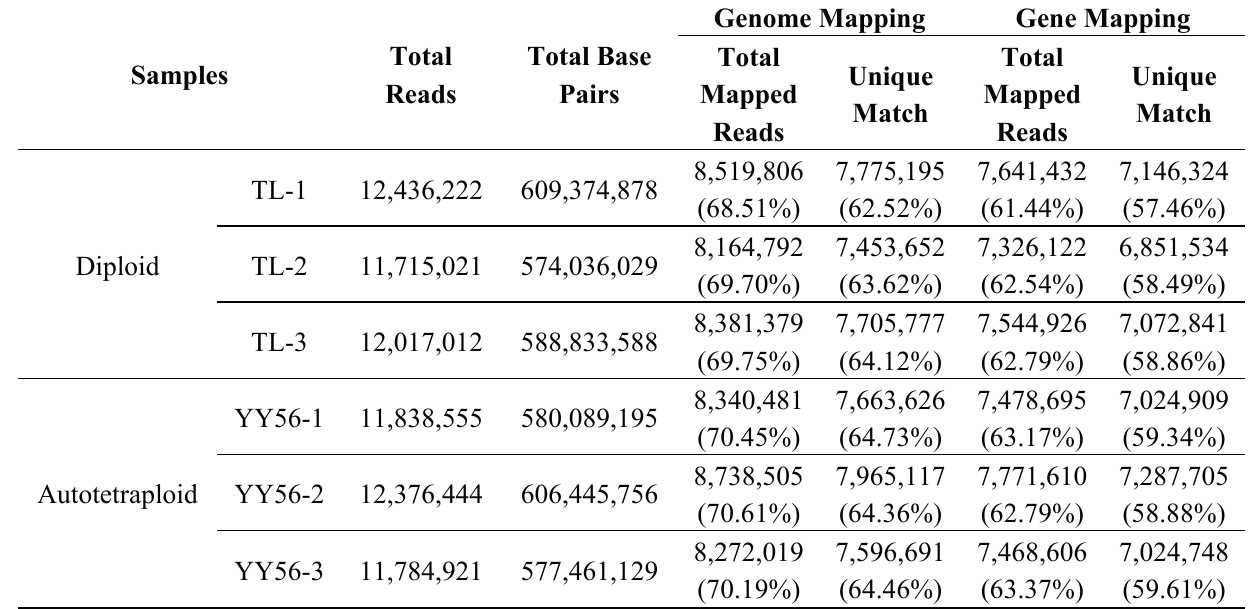
Table 2. The mapping of the sequencing data to the mulberry